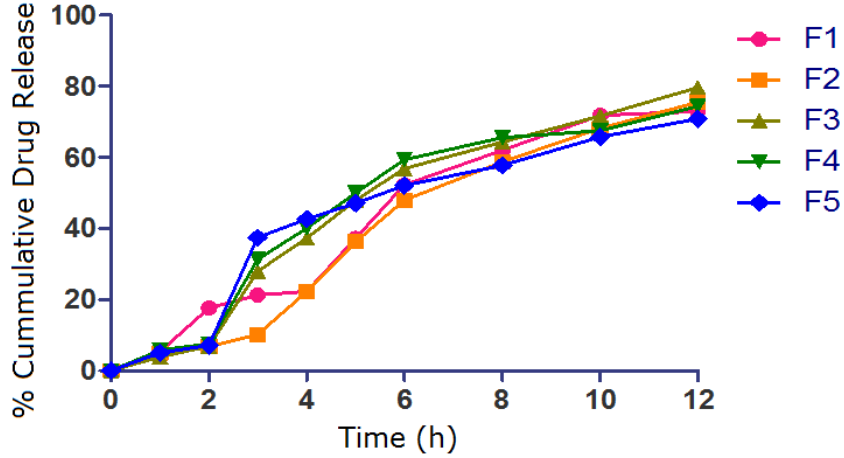
Figure 1. SEM photograph of formulation F3 Table II. Micrometric properties of DBM hollow microspheres Bulkdensity Tapped Formulations